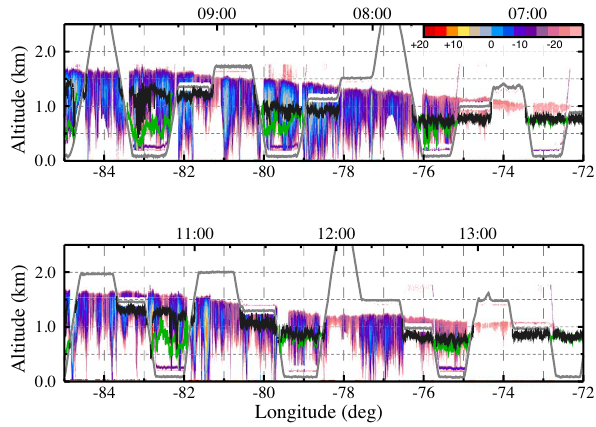
Fig. 2. Longitude-height plot of WCR reflectivity along 20 ◦ S for the outbound (top) and return (bottom) portions of C130 RF03. During subcloud legs, the in-situ LCL (green) and the WCL cloud base (black) are superimposed. During cloud legs, the black line shows the cloud base adiabatically derived from in-situ LWC. The grey line traces the aircraft flight track; the top axis labels show UTC